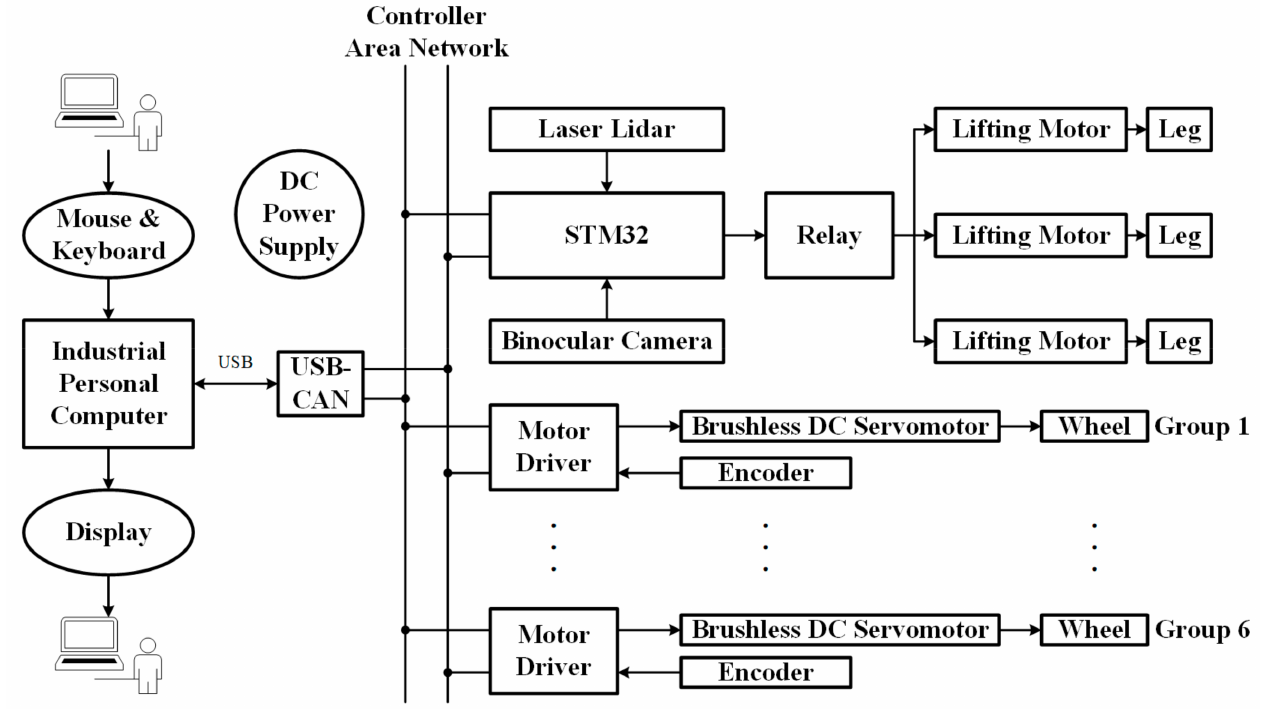
Figure 4. Schematic diagram of the hardware structure of the control